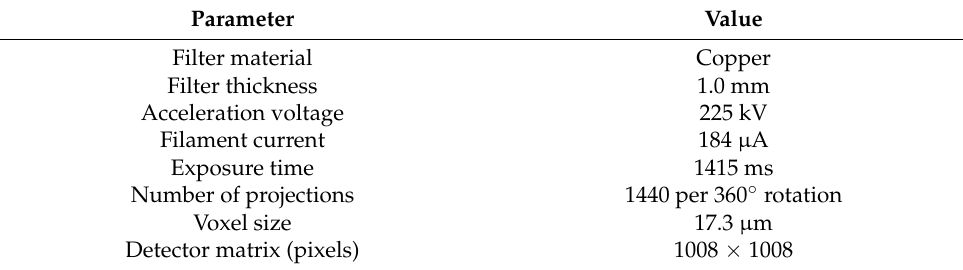
Table 3. Measurement settings for the Nikon CT.